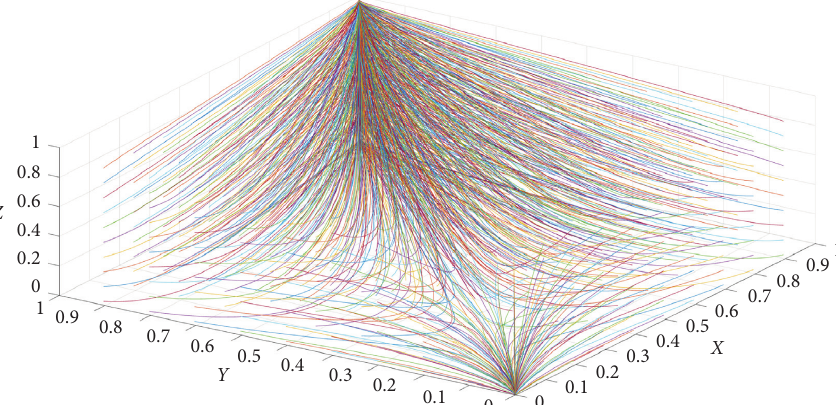
Figure 4: Evolution paths of scenario 4.